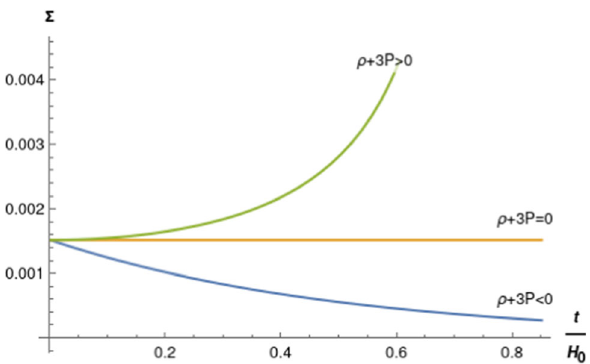
Fig. 1 ThefutureevolutionoftheHubbleanisotropy (cid:2) ( t ) inthecaseof elastic tidal forces with ω 0 = H 0 , H 01 / H 0 = 1 . 001, H 02 / H 0 = 1 . 002 and H 03 / H 0 = 0 . 997. For ρ < − 3P, the anisotropy decreases with time. For ρ > − 3P, it